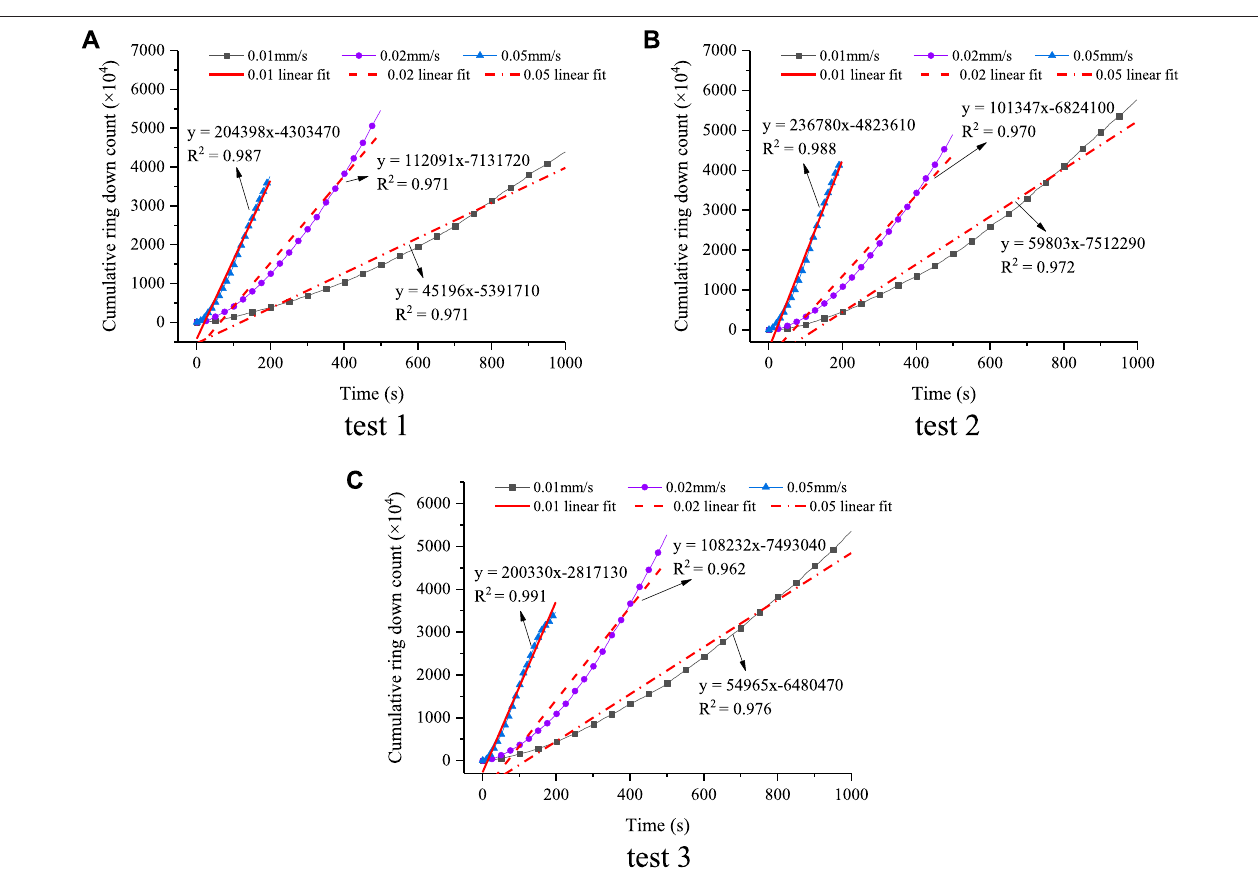
FIGURE 10 | Cumulative fl exural guided wave ring down count versus time with different deformation rates.